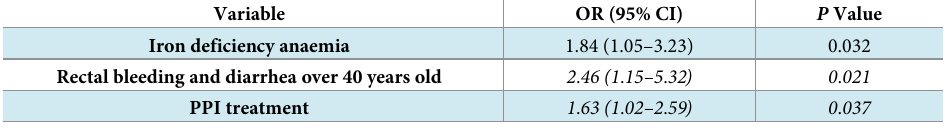
Table 5. Multivariate predictors of false positive result of faecal immunochemical test (FIT (cid:21) 20 μg/g) for diag- nosing advanced neoplasia.